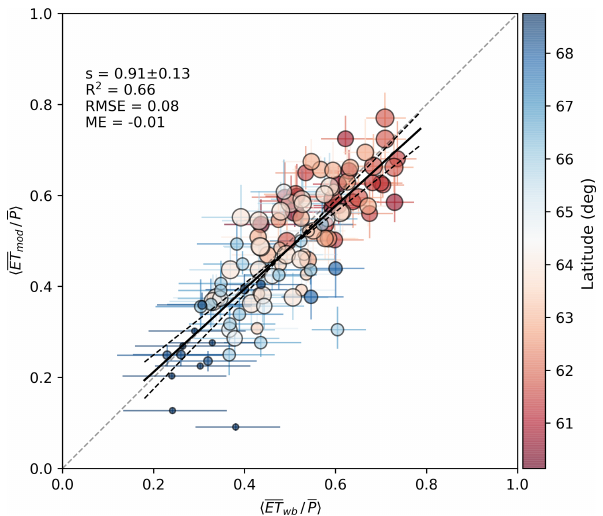
Figure 6. Modeled annual catchment evaporation fraction (cid:10) ET (cid:11) compared to that inferred from catchment water bal- mod /P ance (cid:10) ET wb /P (cid:11) . The vertical and horizontal error bars show the effect of parameter uncertainty and that of catchment area and P , respectively (see text). The colors refer to latitude and symbol size to catchment mean LAI (from 0.2 to 4.6m 2 m − 2 ). Using median year for each catchment ( N = 21), the respective statistics are slope s = 0 . 99 ± 0 . 30, R 2 = 0 . 67, RMSE = 0 . 06, ME − 0 .